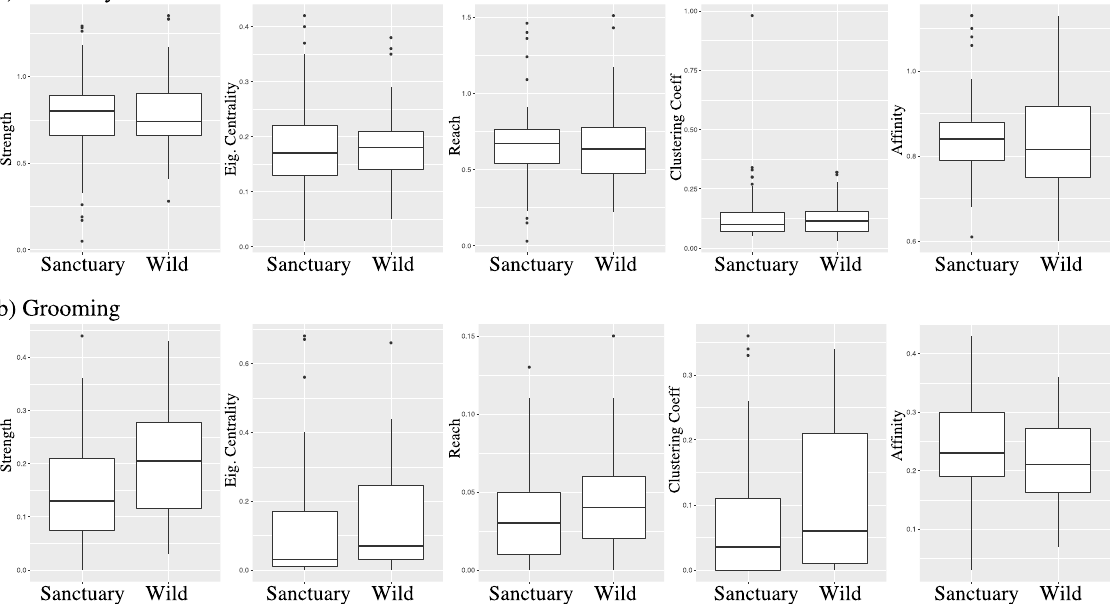
Figure 3. Social network metrics based on ( a ) proximity and ( b ) grooming observations for sanctuary-born versus wild-born chimpanzees. None of the social metrics indicate a significant difference in sociality between chimpanzees with qualitatively dissimilar backgrounds.